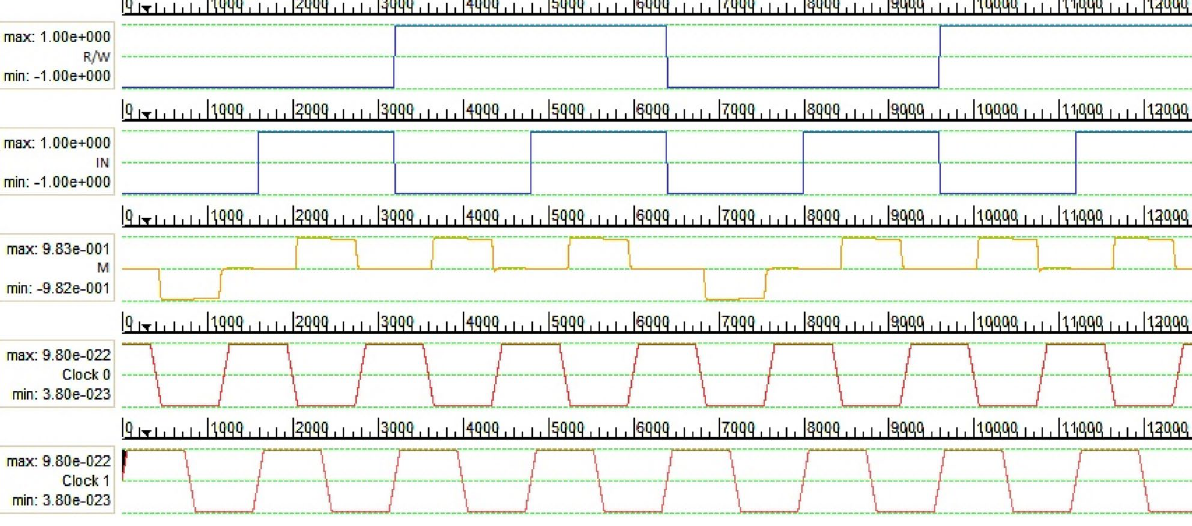
Fig. 15 The results of the developed memory unit